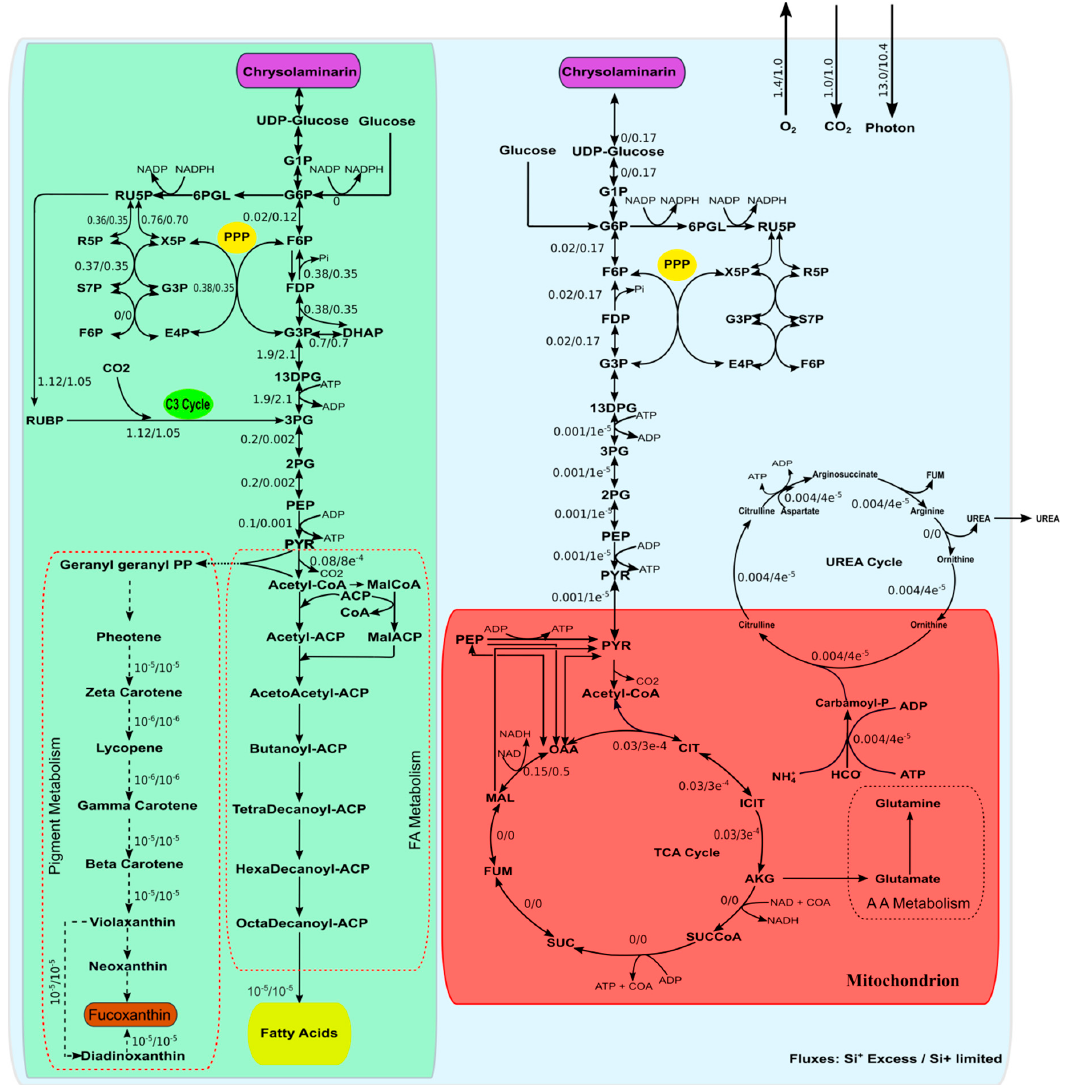
Figure 2. Flux-map showing flux distributions under Si-rich/Si-limited condition. Chloroplast are shown in green color while mitochondria are shown in red. Photosynthesis, lipid, and fucoxanthin synthesis occurs in chloroplast while the TCA cycle and part of the urea cycle occurs in mitochondria. Other major pathways are located in cytosol. The flux through pathways was simulated by fixing the measured growth rate and using the minimization of total flux as the objective